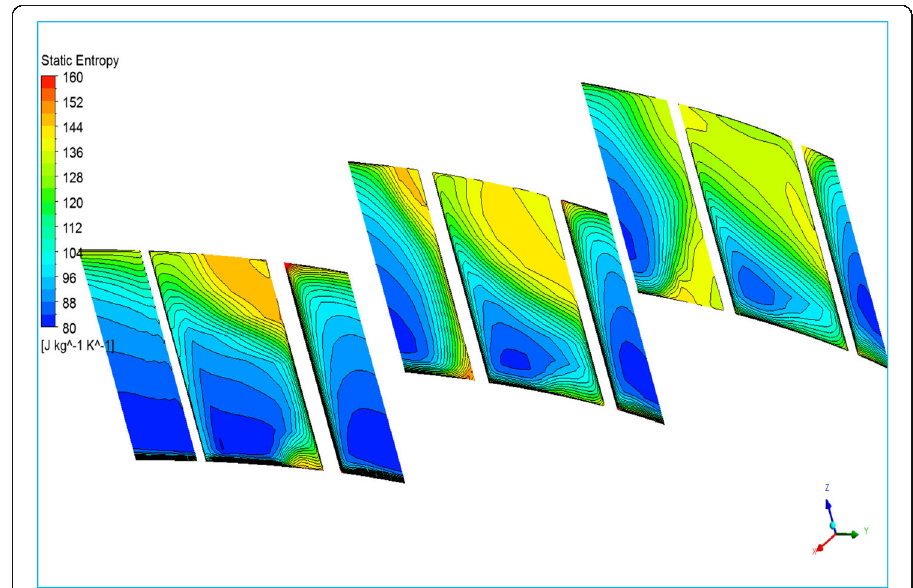
Fig. 15 Entropy distribution at 30, 60, and 90% chord of diffuser-1 for original configuration